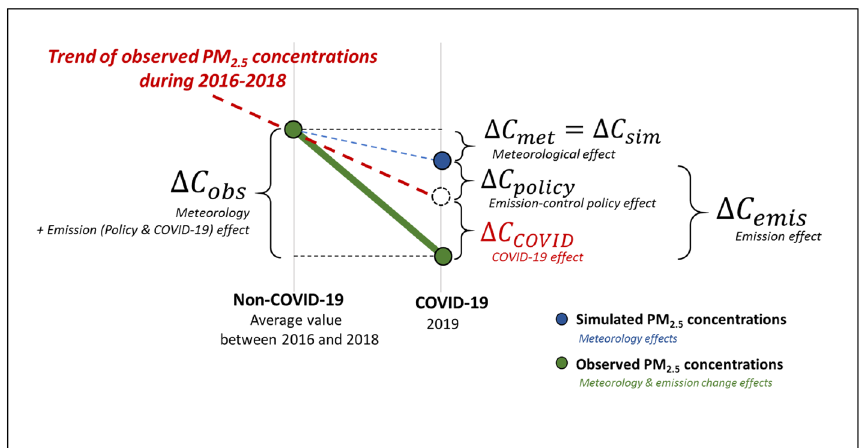
Figure 4. Schematic for the method of separating the impact of COVID-19 from meteorological and emissions control policies on the PM 2.5 concentration change in Northeast Asia during the COVID-19